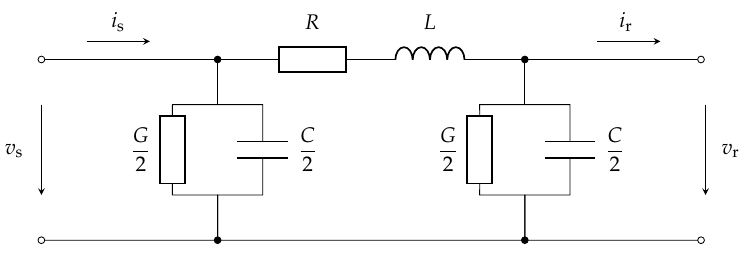
Figure 4. Traditional PI-section without the frequency dependence.